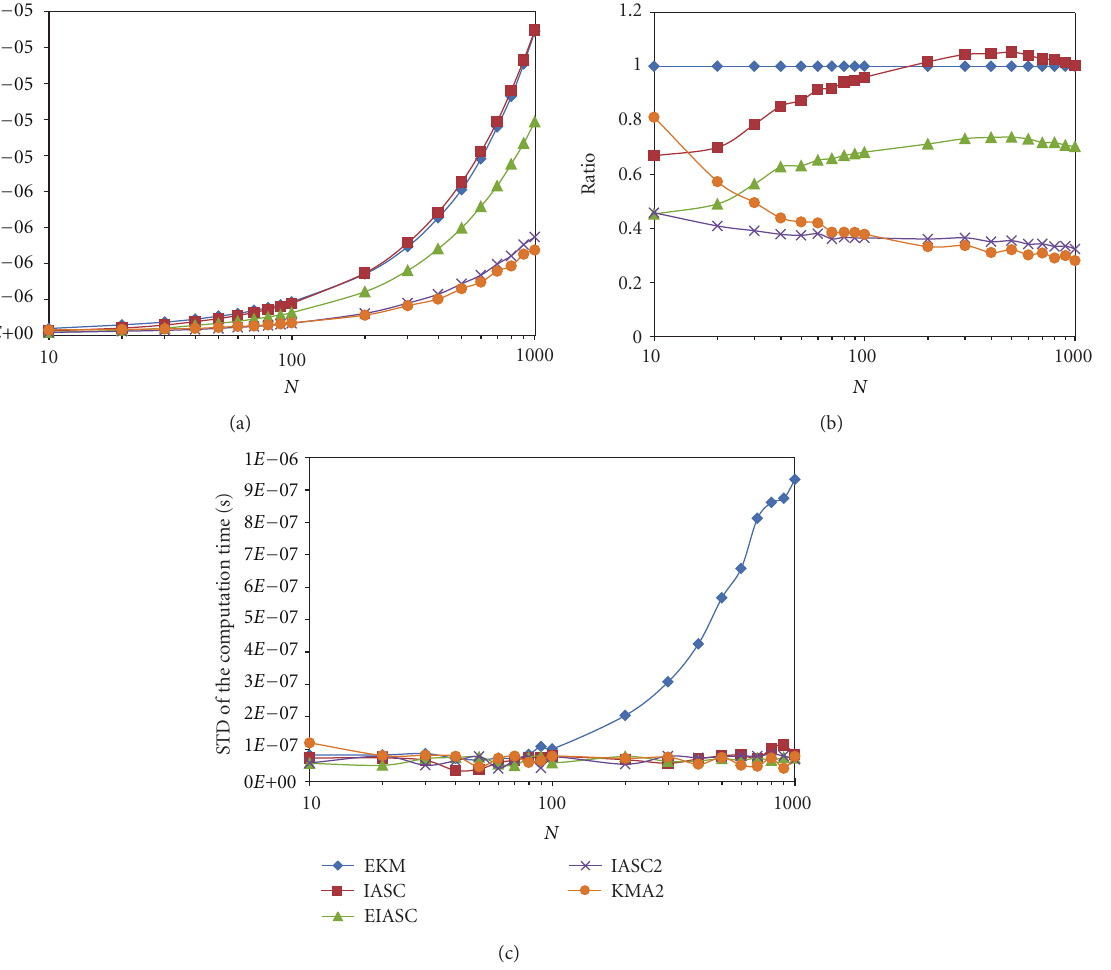
Figure 6: Right-sided random FOU results (compiled language implementation of the algorithms). (a) Average computation time, (b) ratio with respect to the EKMA, and (c) standard deviation of the computation